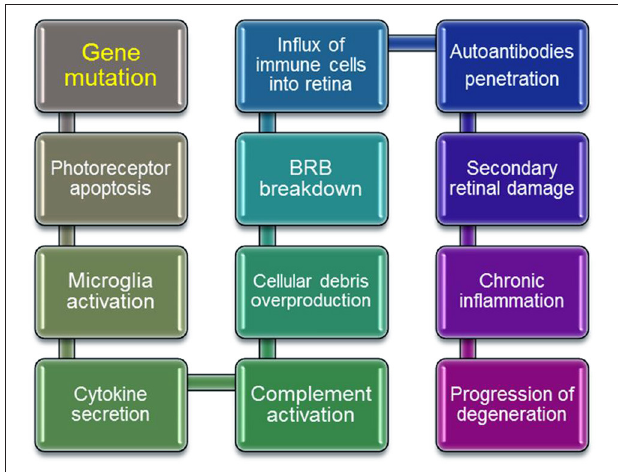
FIGURE 1 | Schematic steps in progressive retinal degeneration. Mutant-proteins accumulate during retinal degeneration and can be seen as new, which can amplify the autoimmune response, ultimately leading to autoimmune pathology. Activation of immune cells by overproduction of cellular debris due to photoreceptor death results in the inner Blood Retina Barrier (BRB) breakdown, which invites systemic macrophages into the retina. Resident and circulating macrophages can contribute to secondary retinal damage from inflammation, and in effect ameliorate retinal degeneration.